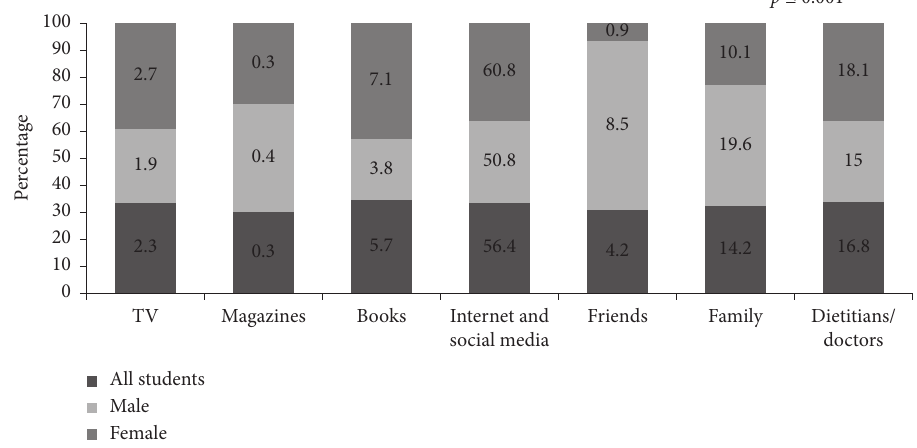
Figure 1: Sources of nutrition knowledge information among study participants.